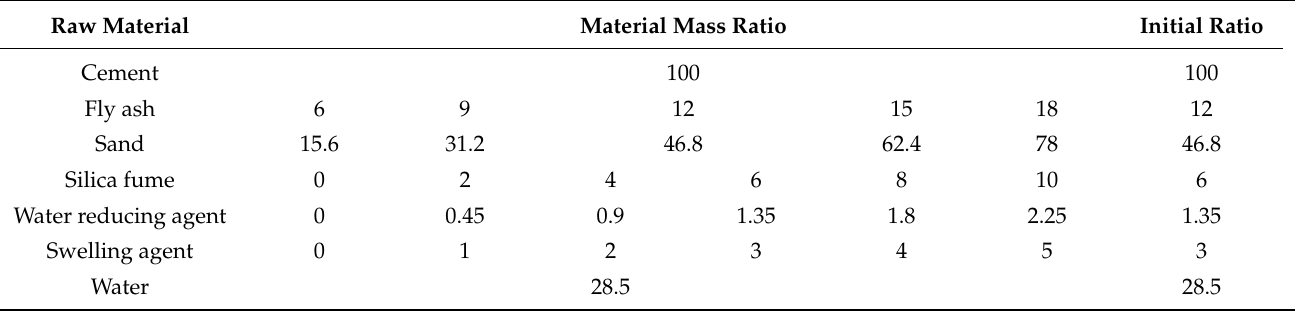
Table 10. The initial ratios of each